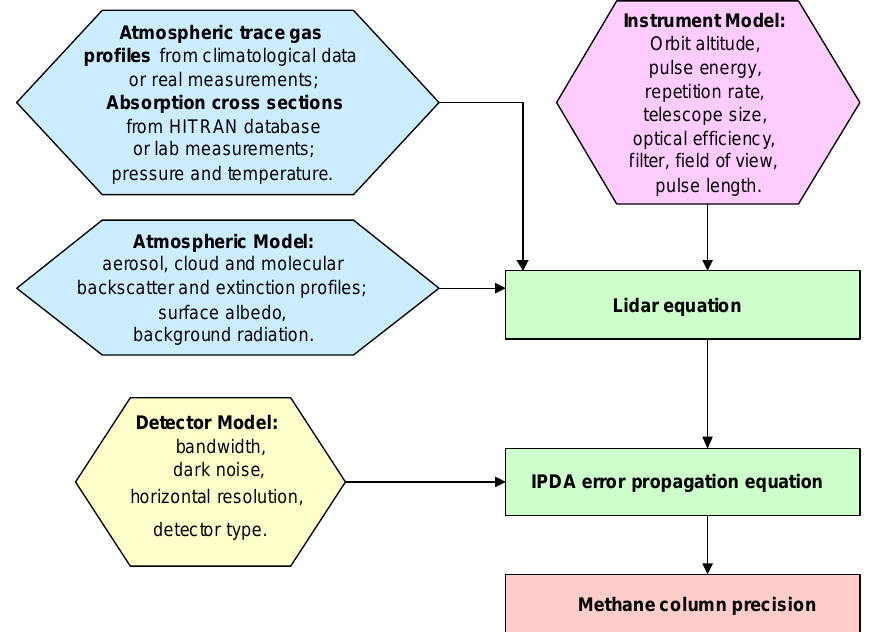
Fig. 5. Main components of the differential absorption lidar simulation model. Input of auxiliary parameters and models in hexagons, core equations and result in